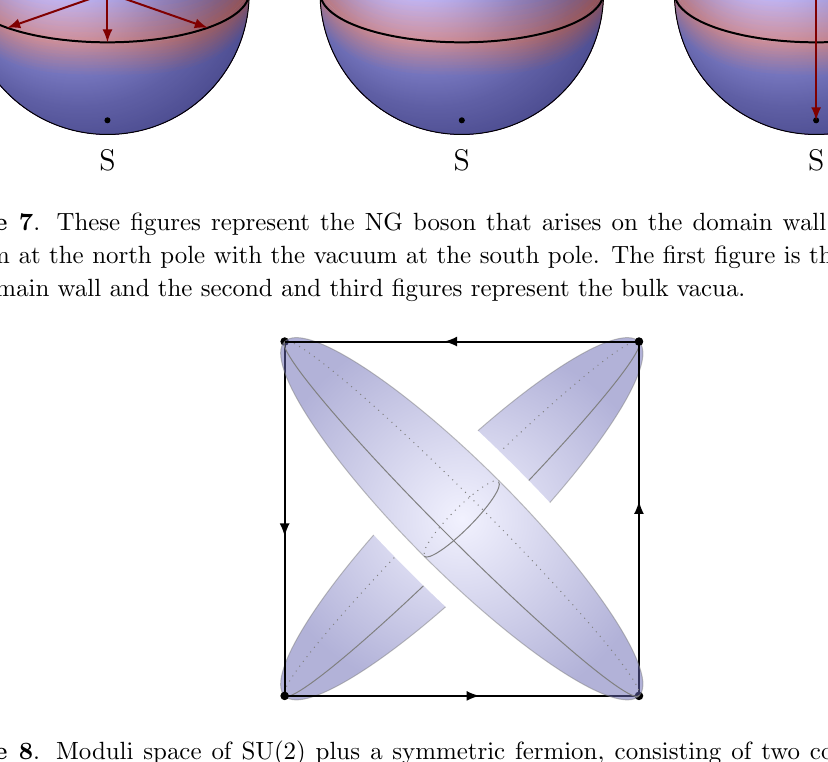
Figure 8 . Moduli space of SU(2) plus a symmetric fermion, consisting of two copies of S 2 (the S 2 ’s in the (cid:12)gure are stretched only for the convenience of the picture). of softly deformed pure N = 2 SYM theory, this result can be derived directly from the Seiberg-Witten solution along the lines of